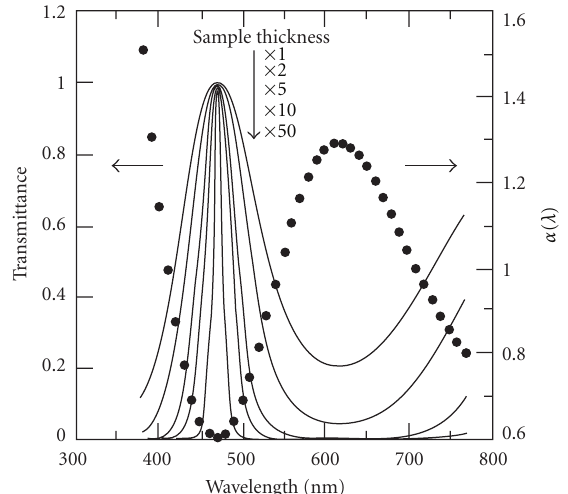
Figure 5: Dependence on thickness of normalized absorbance and transmittance of blue